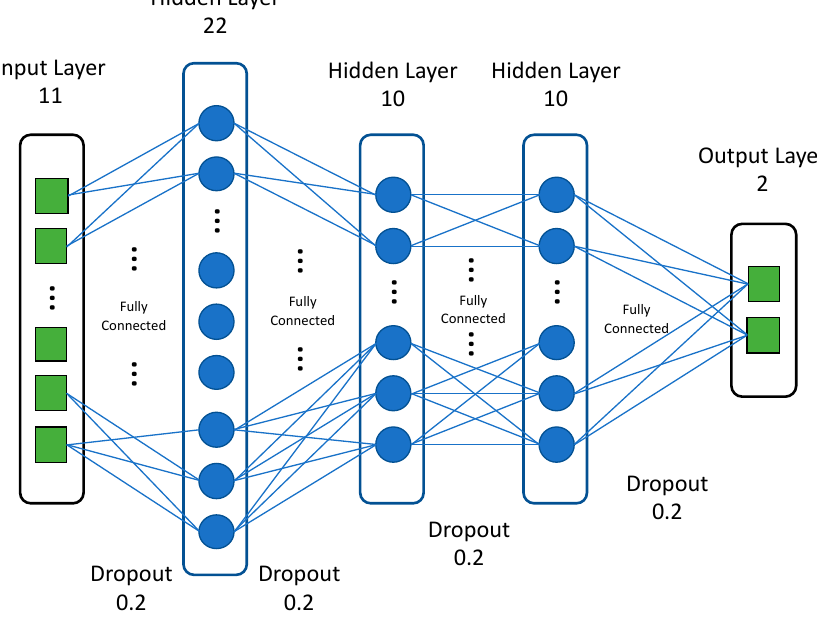
Figure 4. The architecture of the proposed DNN.